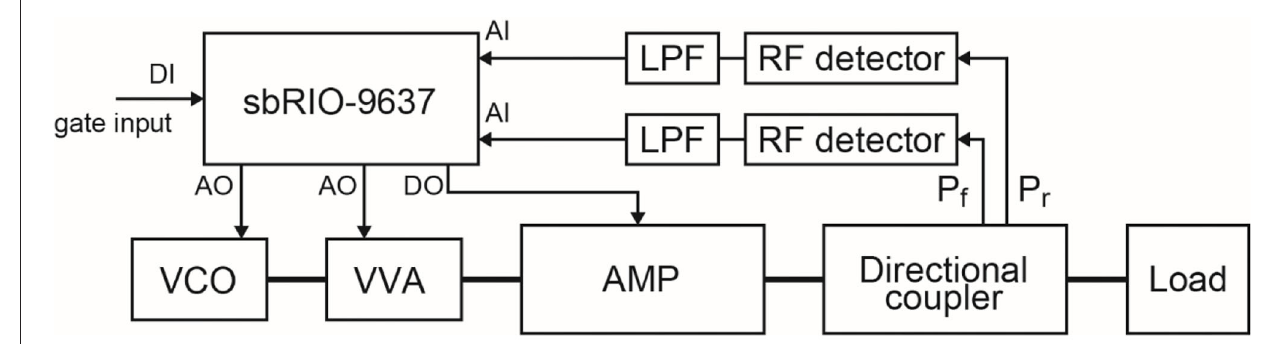
FIGURE 2 | Schematic circuit diagram of the rf